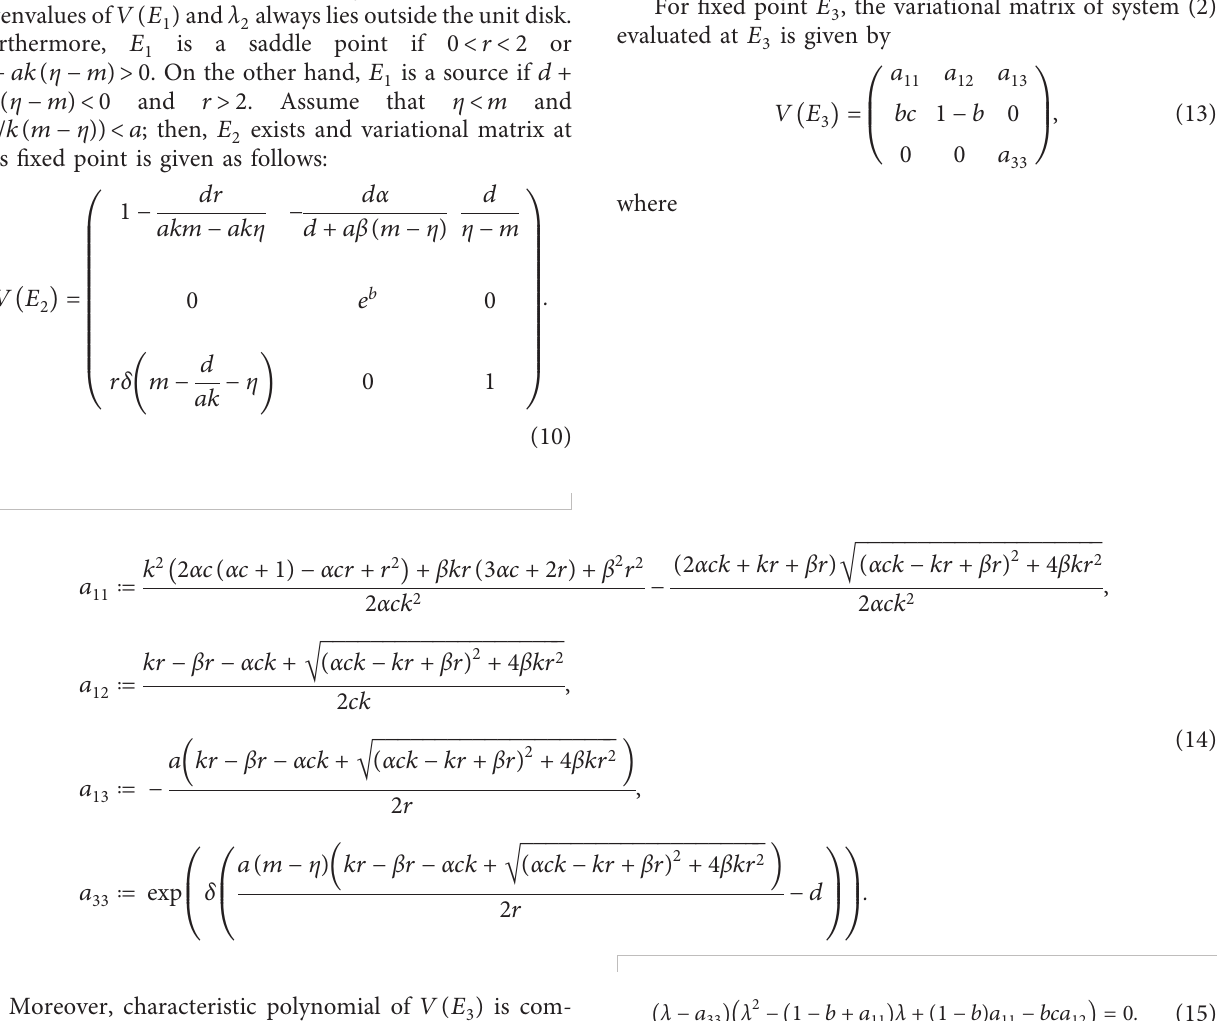
� e − δ ( d + ak ( η − m )) are 3